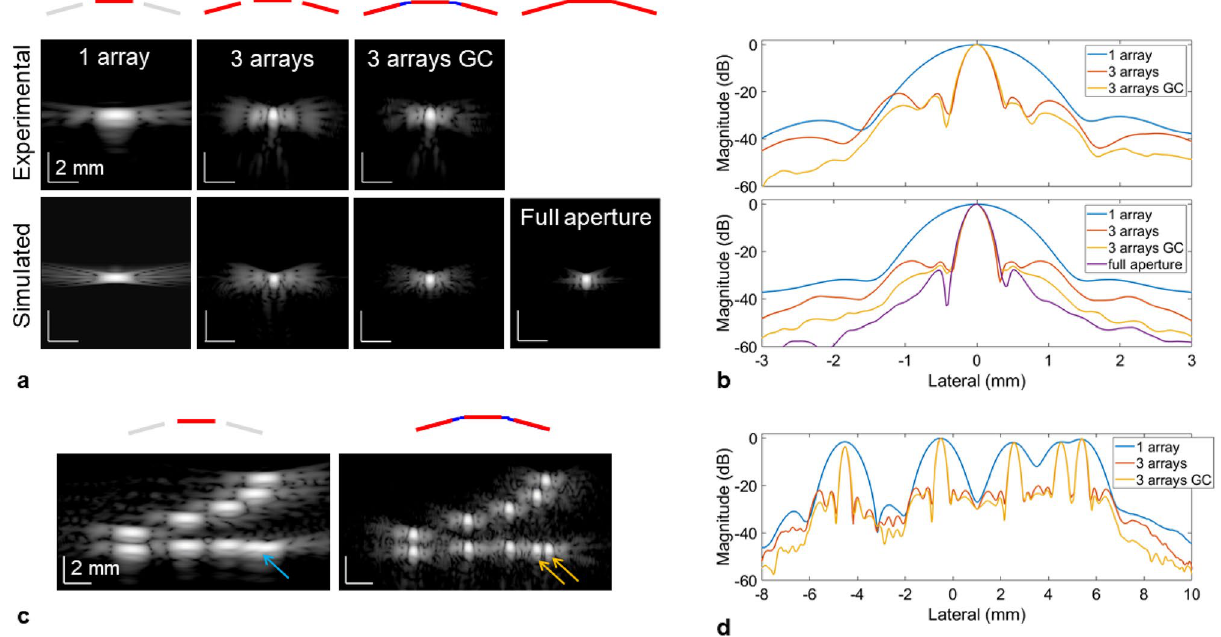
Figure 2. Expanding the imaging aperture effectively improves the resolution as demonstrated by evaluating the point spread function (PSF). ( a ) Comparison of experimental (top row) and simulated (bottom row) PSF for a 25 µm wire located at a depth of 100 mm. From left to right, the columns correspond to the PSF reconstructed using the central array only, all three arrays, all three arrays with gap compensation and an equivalent fully populated aperture (i.e. no gaps). ( b ) Lateral cross-section of the PSF displayed in ( a ). ( c ) Image of wire targets with known spacing (lateral spacing 1–4 mm with 1 mm increment, axial spacing 1–5 mm with 1 mm increment) located at a depth of 100 mm using the central array only (left) and all three arrays with gap compensation (right). The wires spaced 1 mm laterally cannot be resolved laterally with one array (blue arrow) but are fully separated using three arrays (orange arrows). ( d ) Lateral cross-section of the targets aligned horizontally displayed in ( c ). For ( a ) and ( c ) the dynamic range is 60